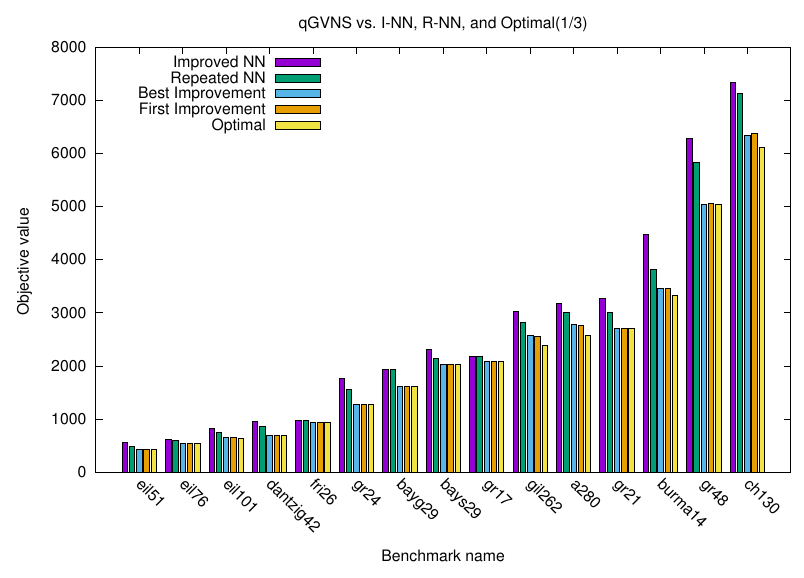
Figure 4. NN variants vs. GVNS vs. OV (1/3).